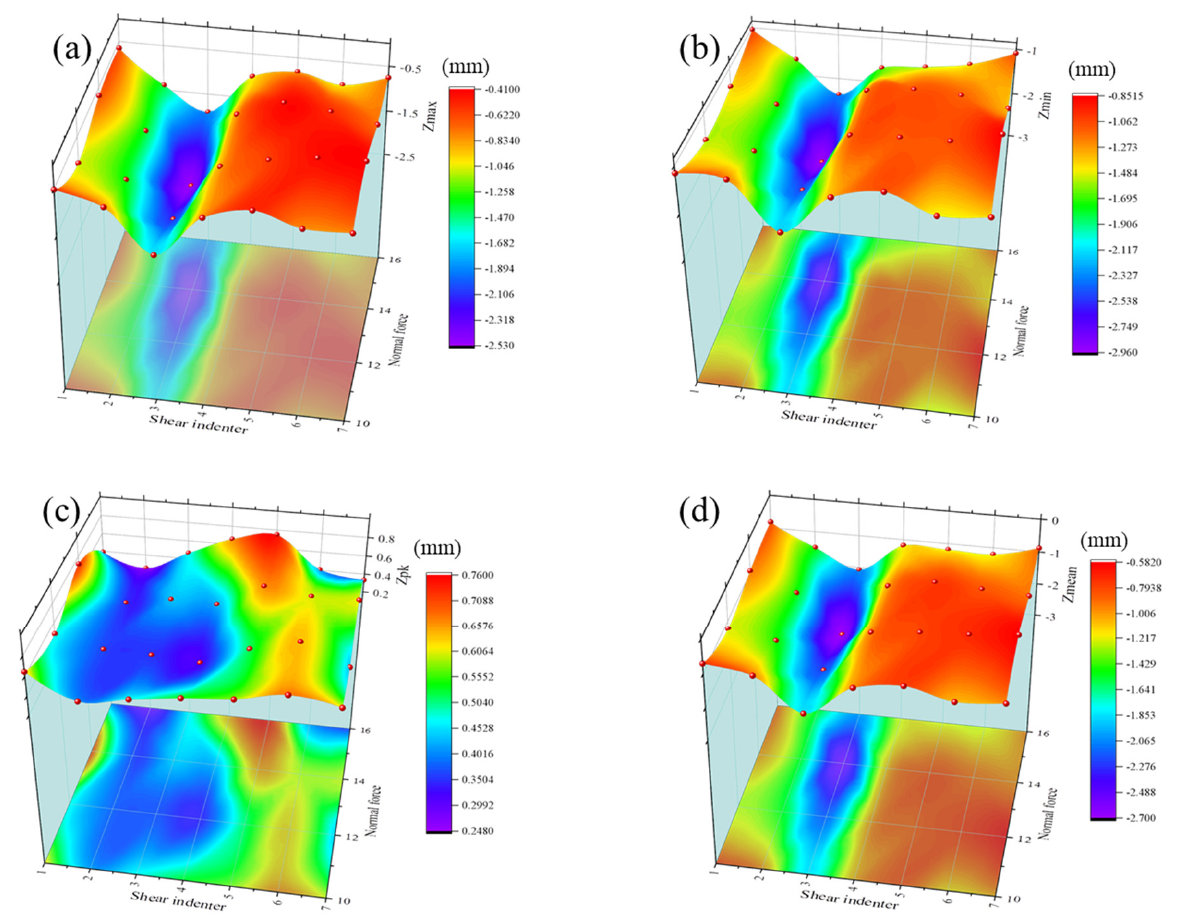
Figure 15. 3D clouds of characteristic parameters in the pressed-in area for different shear indenters and normal forces: ( a ) Z max ( b ) Z min, ( c ) Z pk ( d ) Z mean.